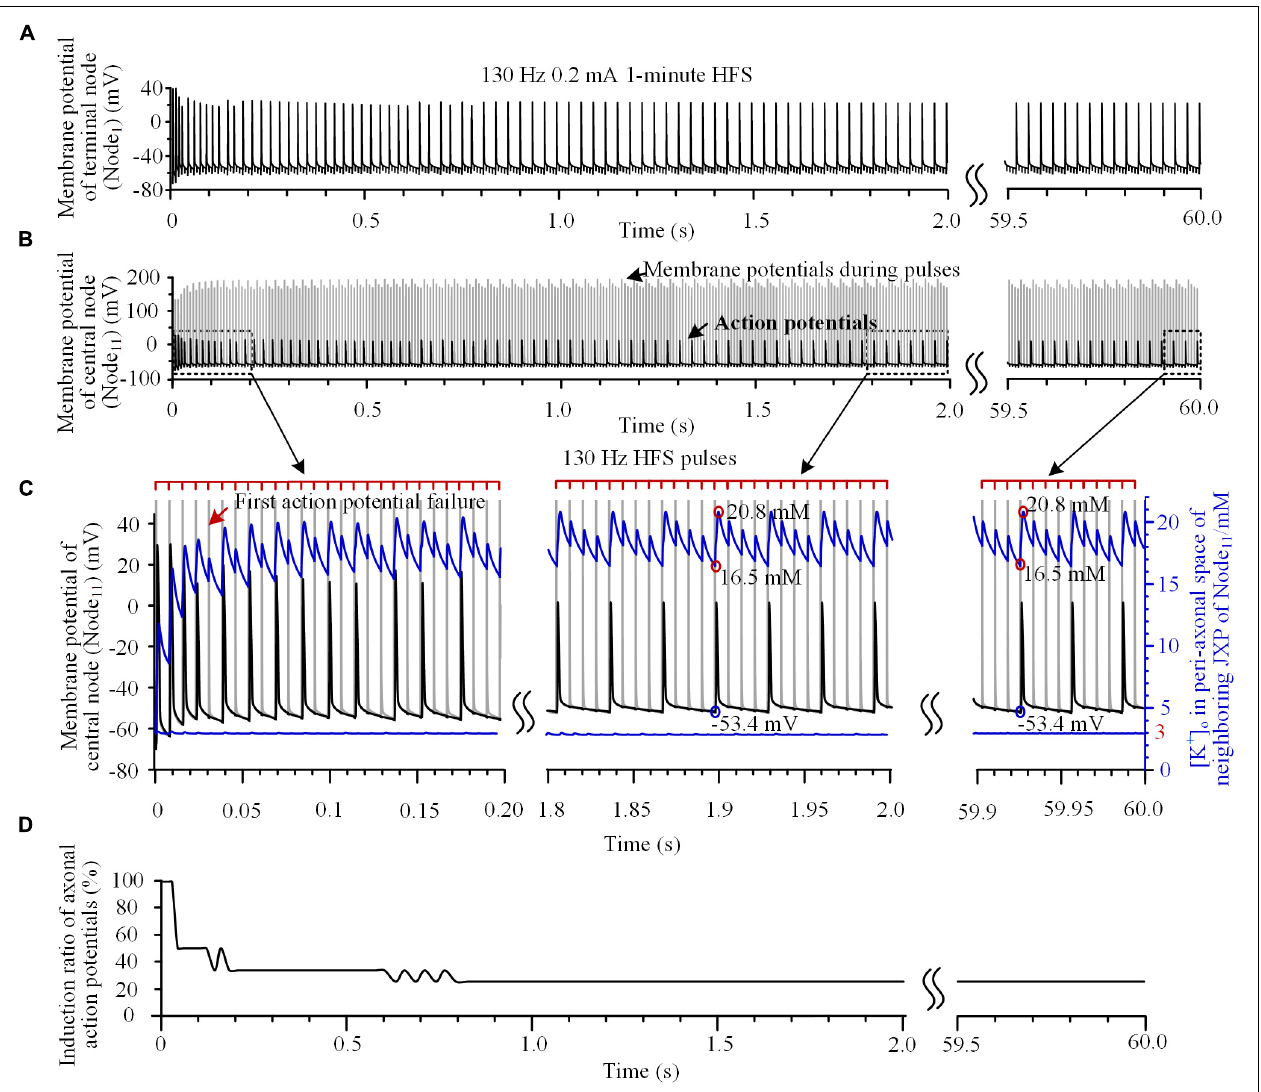
FIGURE 2 | Action potentials and [K + ] o induced by high-frequency stimulation (HFS). (A , B) Membrane potentials recorded simultaneously at the end node (Node 1 ) and the central node (Node 11 ) during a 1-min train of 130 Hz pulse stimulation with 0.2 mA intensity. For clarity, recordings in 2.0 ∼ 59.5 s are omitted. (C) Magnified plots of membrane potentials at Node 11 (black curves), [K + ] o at Node 11 (blue curves below) and [K + ] o in the peri-axonal space of neighboring JXP (blue curves up) during the first 0.2 s, middle 1.8 ∼ 2.0 s and last 0.1 s of the 1-min HFS. Cathodic monophasic pulses of extracellular HFS are represented by the tick marks on the red lines above. The gray curves in (B,C) represent changes of membrane potentials induced by pulses at Node 11 . These large potentials are trimmed in the enlarged plots in (C) . (D) Change of induction ratio of axonal action potentials by pulses of HFS.